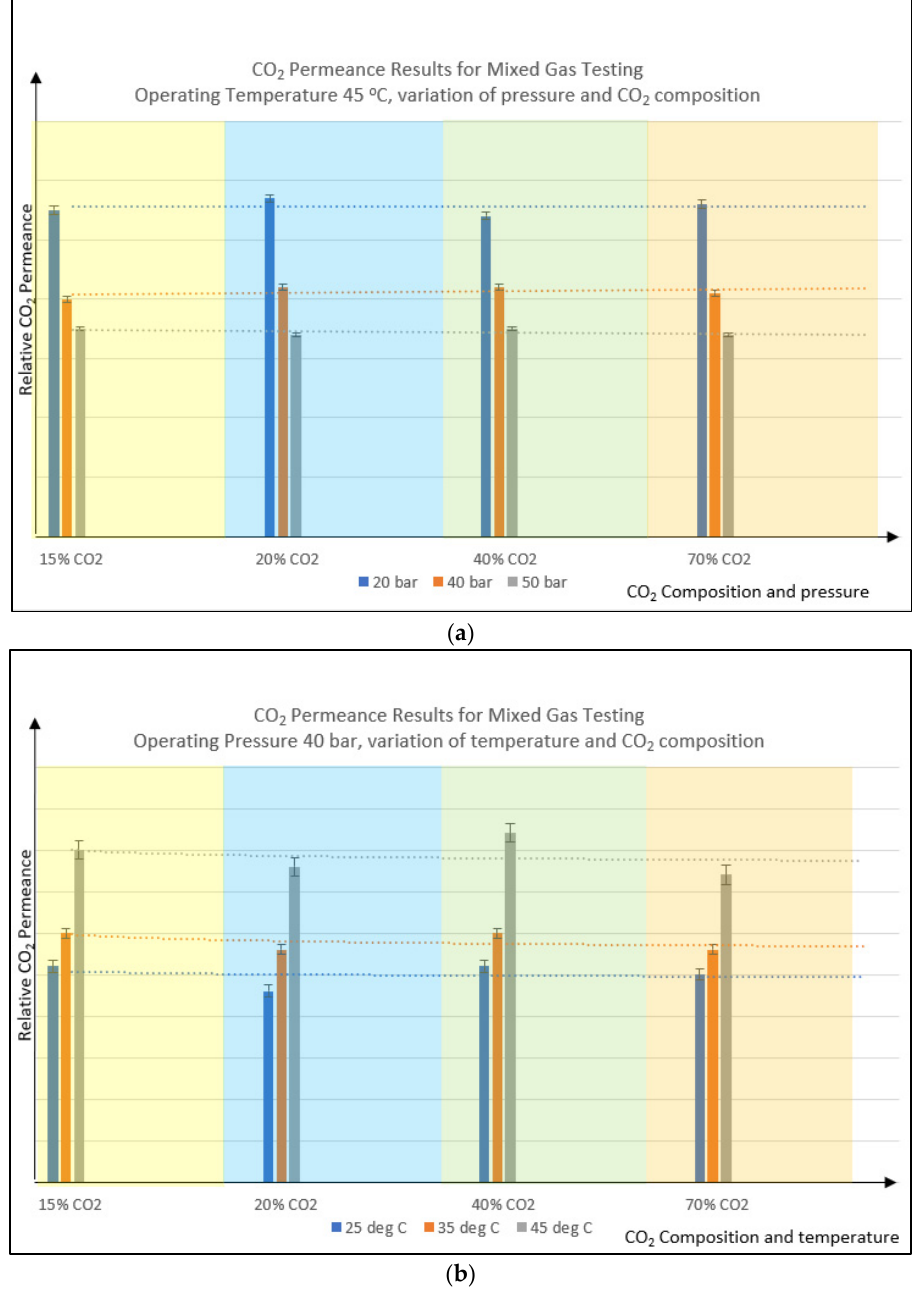
Figure 8. Relative CO 2 permeance vs. variation of CO 2 feed composition; varies operating pressure ( a ) and varies operating temperature ( b ). Dotted line is the trendline as a guide.